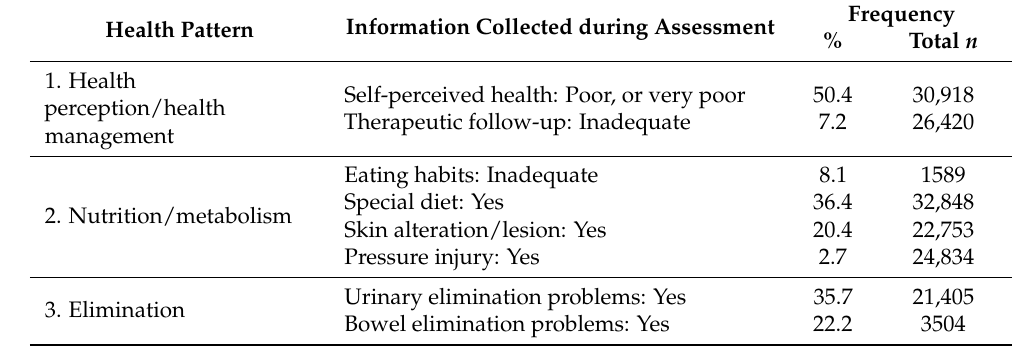
Table 3. Characteristics of highly complex chronic patients according to assessment by health